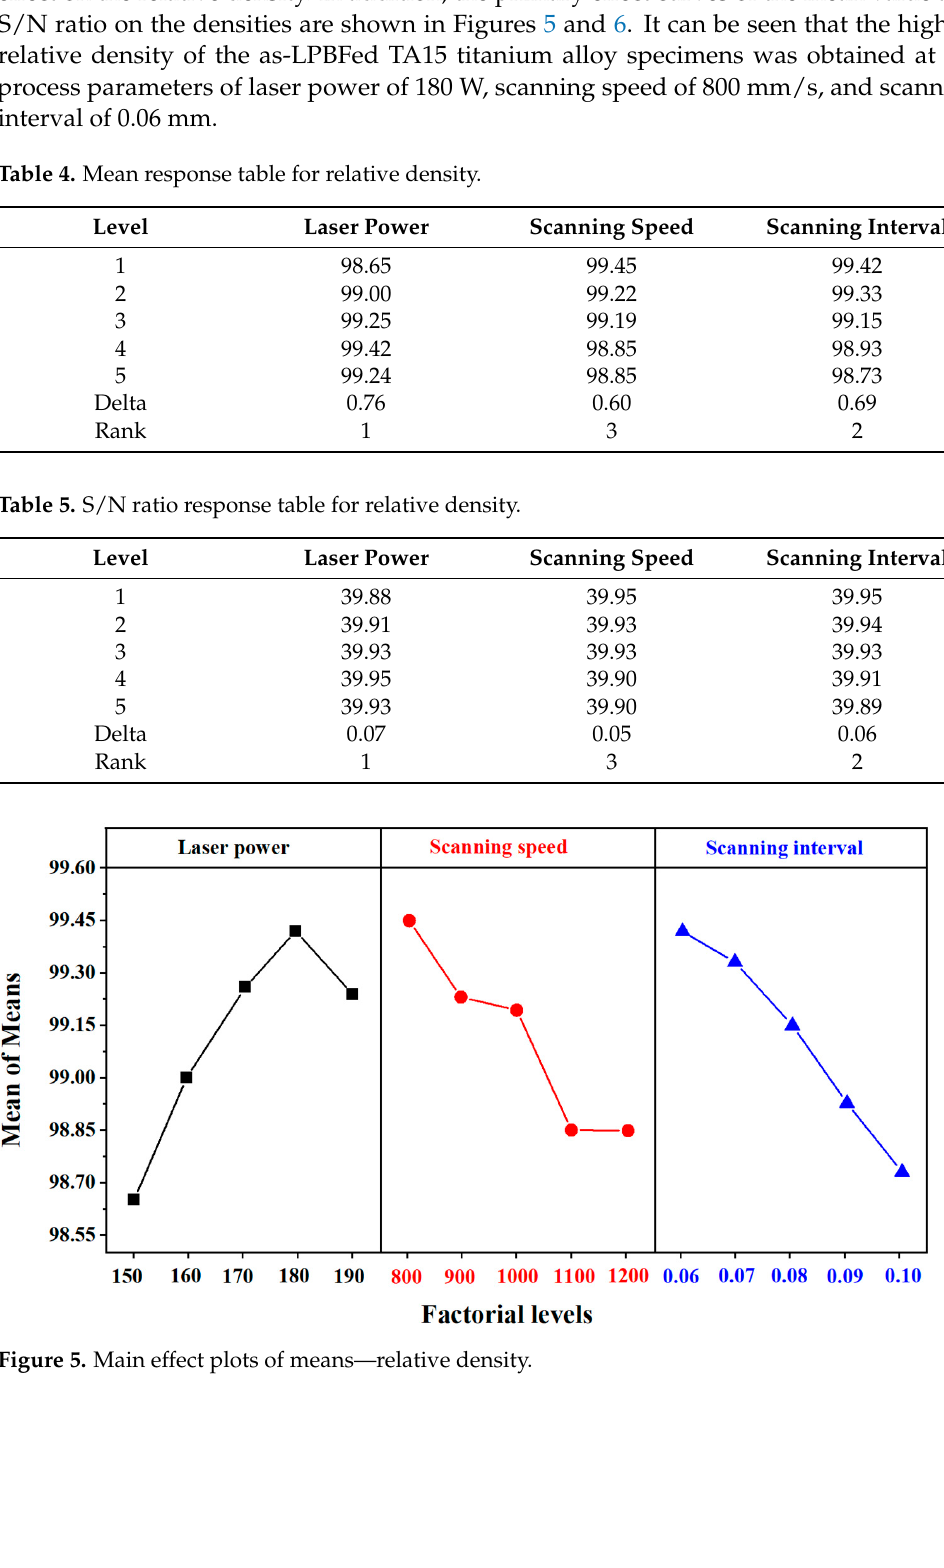
Figure 6. Main effect plots of S/N ratio—relative density. 3.2.2. Analysis of Variance (ANOVA) The percentage contribution of every parameter was calculated by ANOVA. ANO- VA facilitated the formal testing of the results of all the main factors and their relation- ships by assessing the mean squared deviation of the experimental error approximation at a defined confidence level. In this study, the percentage contribution of each process parameter to obtain the best molding quality of the specimen was performed by MINITAB software. The most significant process parameter obtained by calculating the percentage contribution was the laser power of 33.86%, followed by the scanning inter- val of 31.33% and finally the scanning speed of 25.35%. Table 6 indicates the results ob- tained by ANOVA of the densities. The results show that the laser power was the most significant process parameter affecting the relative density of the as-LPBFed TA15 tita- nium alloy.